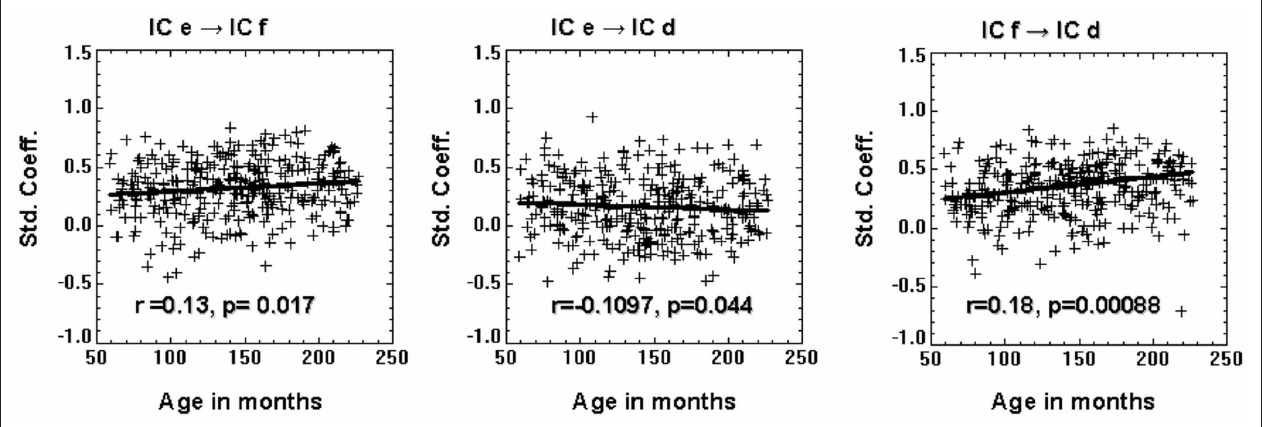
FIguRe 6 | Standardized path coefficients corresponding to the SeM shown in Figure 5 that showed significant changes with age are plotted as a function of age in